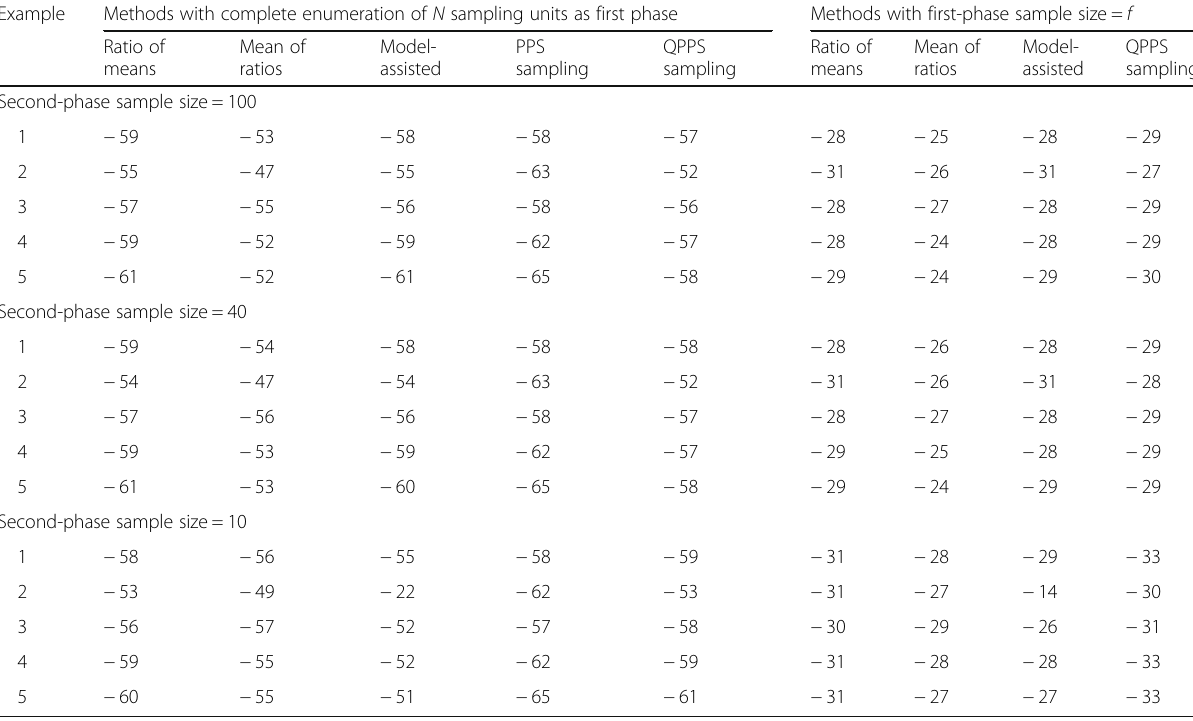
Table 5 Sampling efficiency (%) of the various methods considered here relative to simple random sampling Example Methods with complete enumeration of N sampling units as first